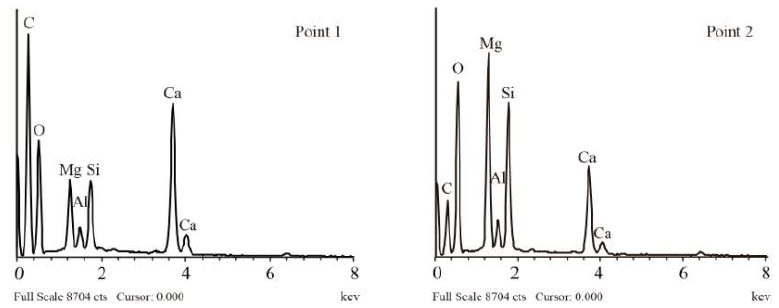
Figure 6. Scanning Electron Microscopy images of binder mortar: ( a , b ) fine fraction and ( c ) ultrafine fraction. Point 1 and point 2 indicate the particles analysed by EDX.